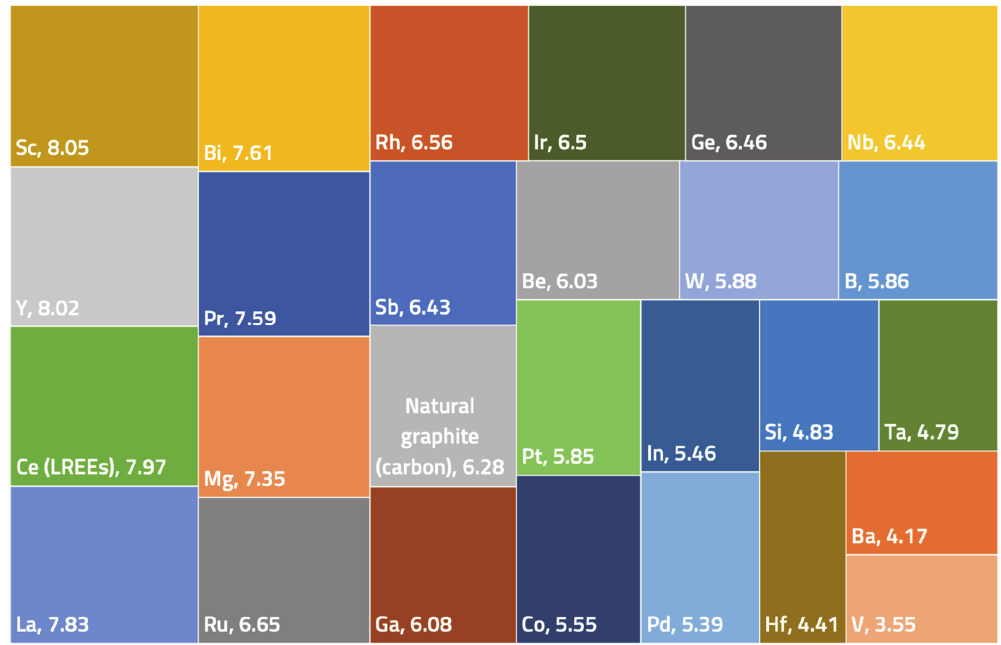
Figure 1: Criticality grade of different CRMs measured by the RM Criticality Indicator (k = 1 for all the